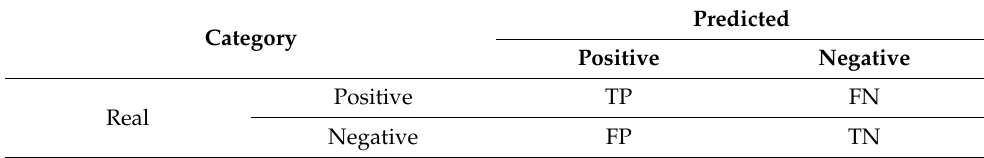
Table 1. Confusion